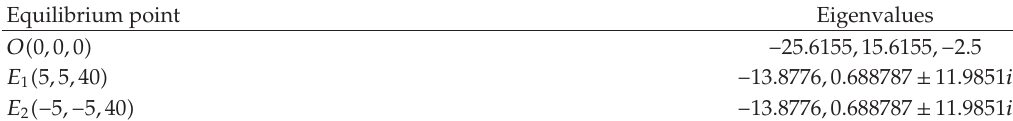
Table 1: Equilibrium points and corresponding eigenvalues.